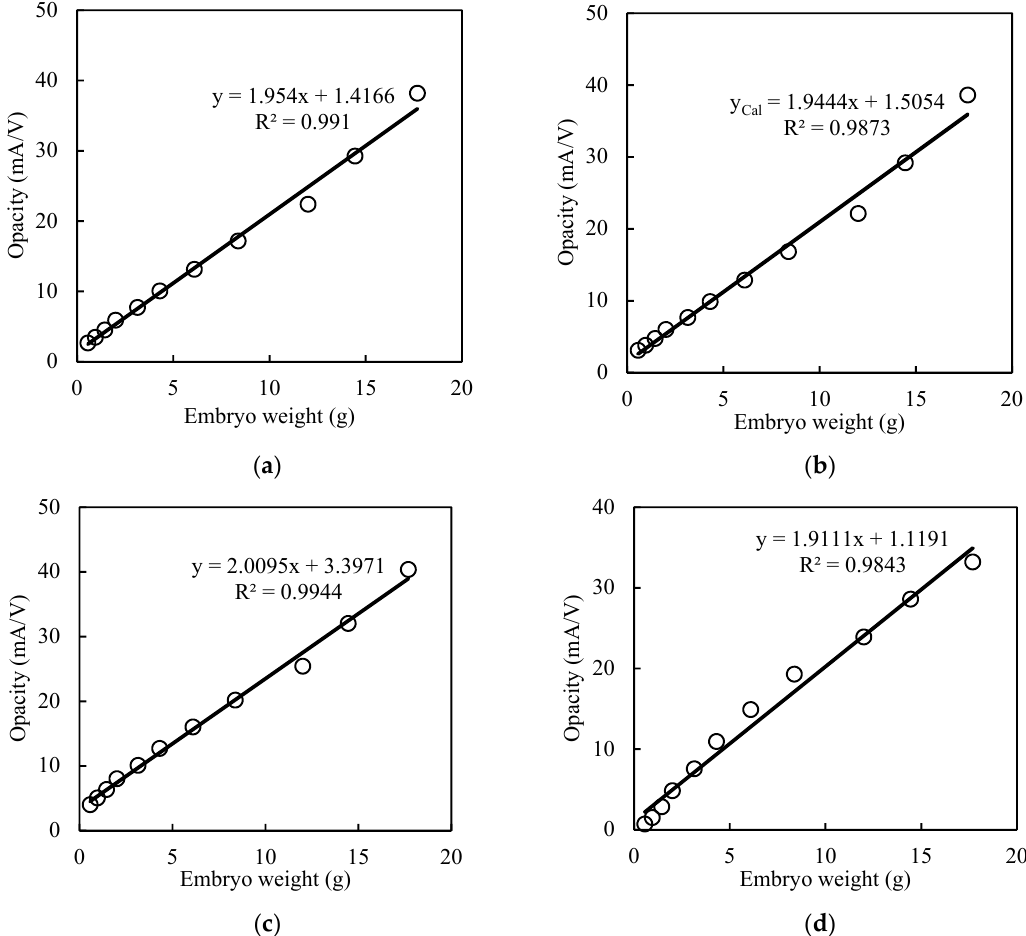
Figure 6. Correlation between calculated opacity by various mathematical models and embryo weight (small eggs group). ( a ) exponential fit, ( b ) sigmoid fit, ( c ) power fit and ( d ) Gompertz fit. The embryo weight used is from the experiments of Byerly [17].